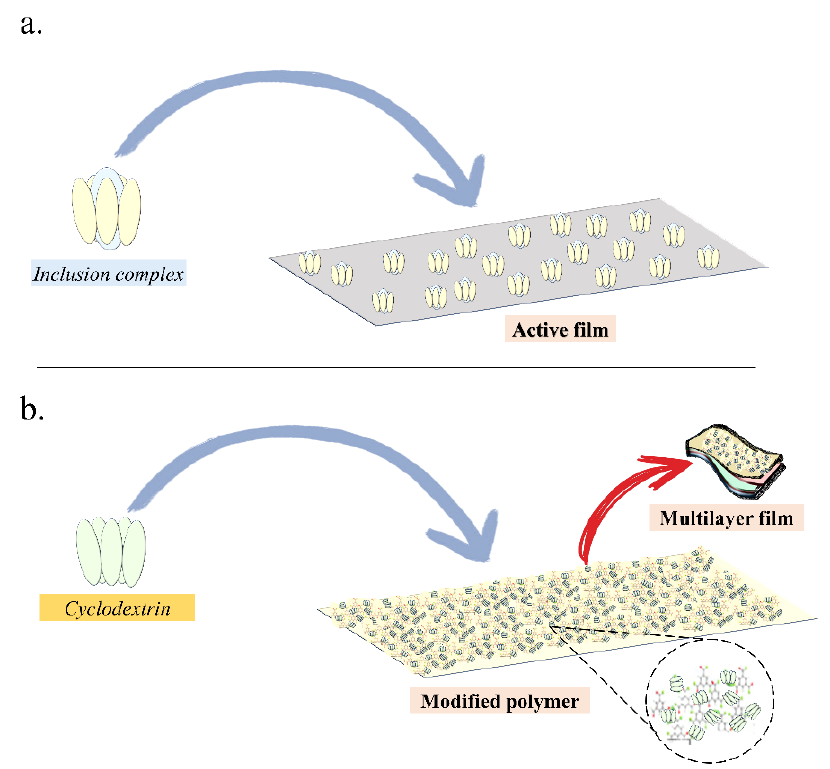
Figure 3. Incorporation of inclusion complex ( a ) or “empty” CD ( b ) into polymer matrices. Chiu et al. [109], in turn, immobilized β -CD in a chitosan matrix to separate cholesterol in egg yolks, promoting the removal of 92% of cholesterol from the analyzed samples. The study also emphasized the reuse capacity of the separation matrix, up to 12 times since cholesterol, after complexed with CD, can be released with an ethanolic solution (95% w / w ) at 50 ◦ C. A process with a similar goal was developed by Dias et al., using β -CD in the removal of cholesterol in butter